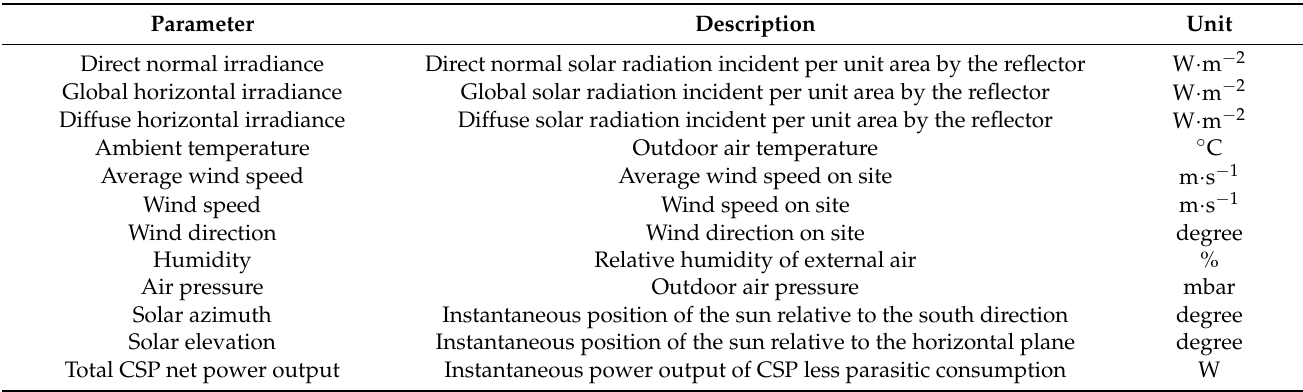
Table 2. All monitored variables of the CSP system.